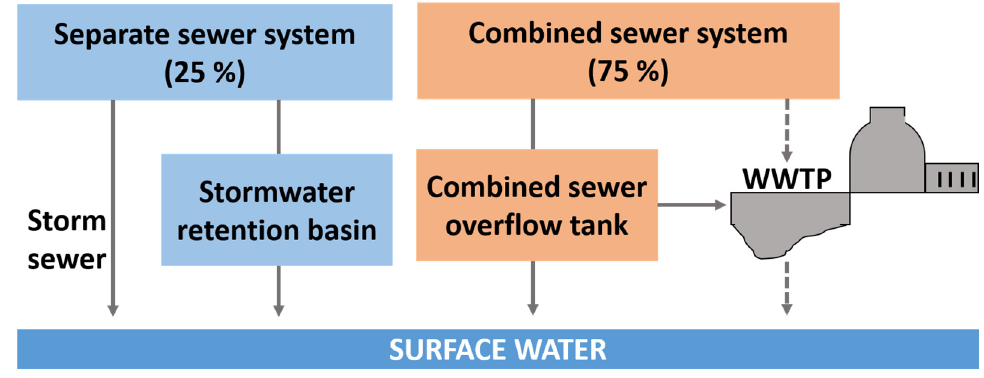
Figure 2. Pathways of sewer systems in the study area, modified after